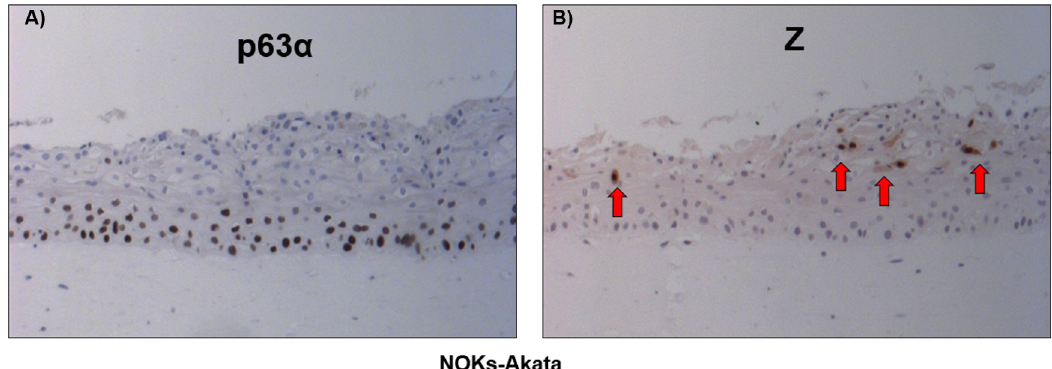
Fig 1. Δ Np63 α and Z expression occurs in different sections of organotypic raft cultures. Immunohistochemistry (IHC) was performed on adjacent sections of organotypic rafts of differentiated NOKs-Akata cells using antibodies against A) p63 α and B) Z. Arrows show examples of Z expressing cells. Results are representative of three independent